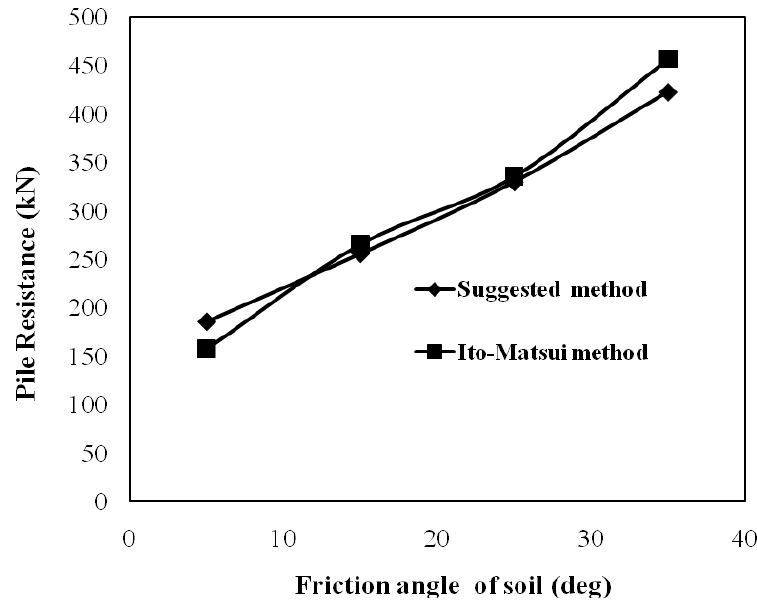
Fig. 5. Comparison between the proposed method to determine lateral resistance of passive pile and Ito and Matsui’s